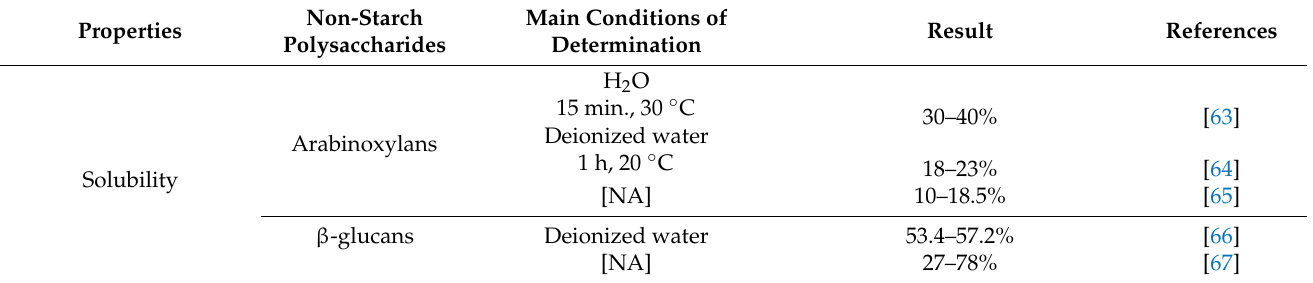
Table 2. Properties of non-starch polysaccharides occurring in cereal-based